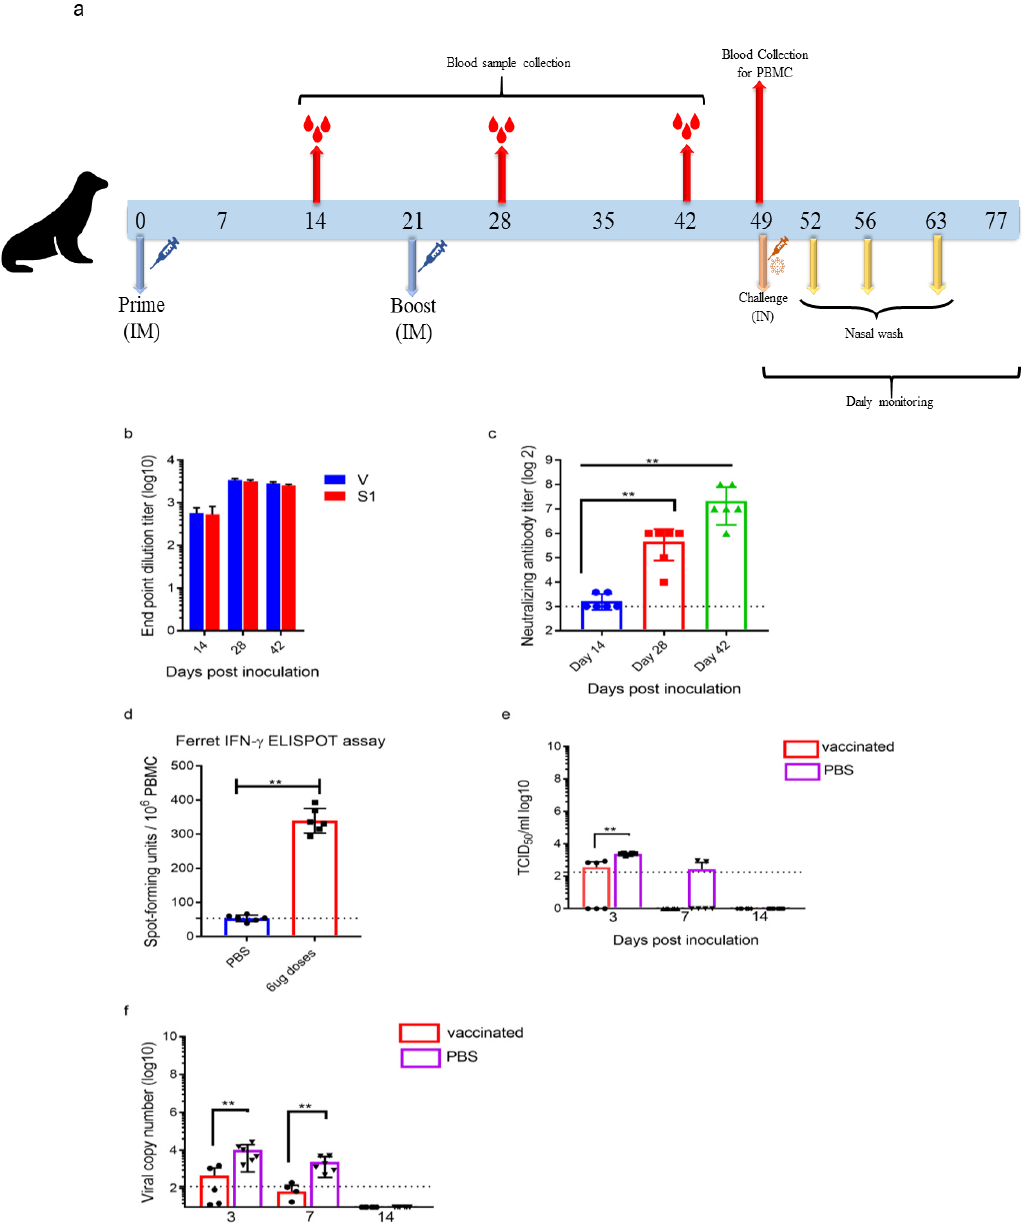
Figure 5. Immune responses and protective efficacy of ERUCoV-VAC in ferrets. ( a ) Scheme of sample collection, immuniza- tion regimens, and SARS CoV-2 challenge. Groups of ferrets ( n = 6) immunized on days 0 and 21 with 6 µ g of ERUCoV-VAC or with a PBS ( n = 6) via the intramuscular route. The ferrets were challenged 4 weeks after the second immunization with 5 × 10 5 TCID50 of SARS-CoV-2 by the intranasal route. ( b ) Serum IgG titres were detected by SARS CoV-2-specific S1-RBD (S1) and virion (V) ELISA in ferrets vaccinated with a 6 µ g dose of ERUCoV-VAC. ( c ) Serum Nab titres determined by microneutralizing assay in ferrets vaccinated with a 6 µ g dose of ERUCoV-VAC. ( d ) Cellular immune responses in the 6 µ g dose group ( n = 6) and control group ( n = 6) were analysed on day 28 following the second immunization by an IFN- γ -based ELISPOT assay. On day 28 after the second immunization, a total of 12 ferrets, both vaccinated ( n = 6) and unvaccinated ( n = 6), were intranasally challenged with 5 × 10 5 TCID50 of SARS-CoV-2. Live virus titres ( e ) and viral load of SARS CoV-2 ( f ) in nasal washes obtained from ferrets according to the indicated timeline after challenge. The dotted line indicates the highest value measured in the normal control group, which was 2.125 log 10 N copy number/mL in the nasal washes. The statistical significance was assessed using a Mann–Whitney test; p values less than 0.01 were considered to be statistically significant where ** denotes 0.01; ns: not significant. Error bars represent mean ± standard